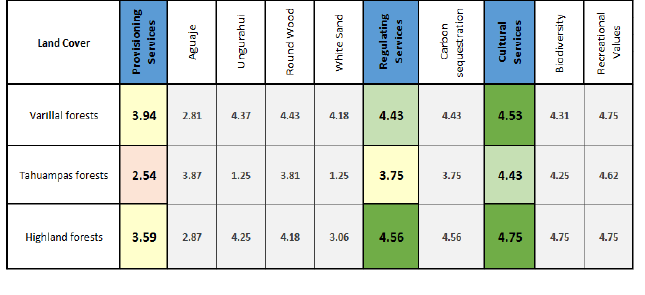
Table 2: Assessment matrix illustrating the supply capacity of different land cover classes to provide ecosystem